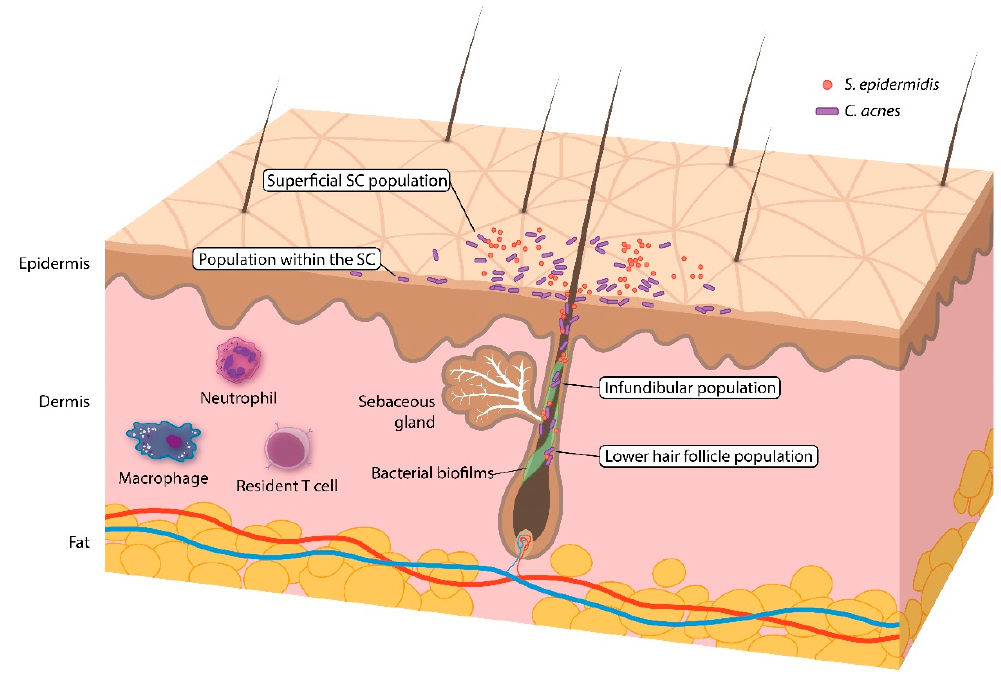
Figure 1. Overview of the skin (pilosebaceous unit) and the C. acnes population within it.